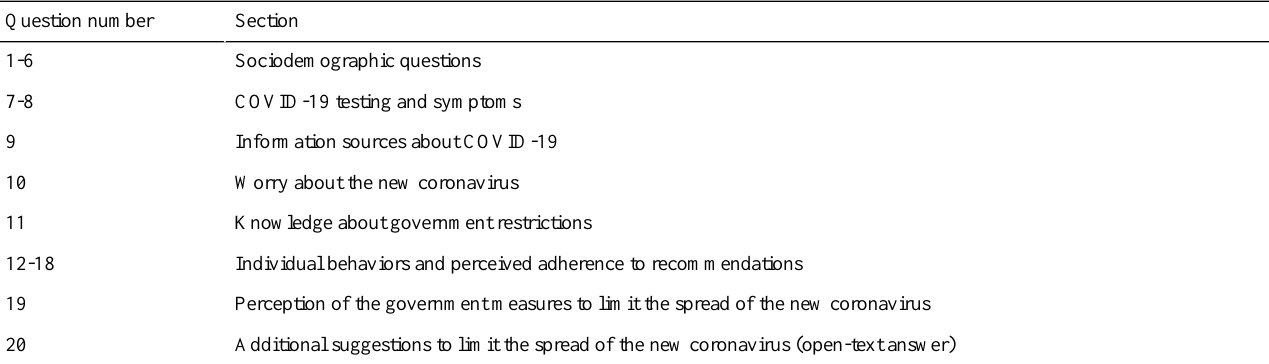
Table 1. Overview of survey